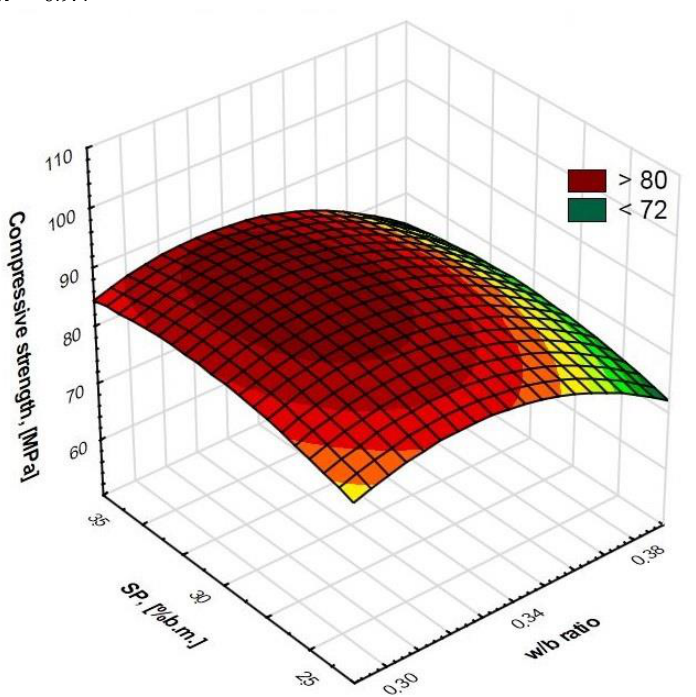
Figure 9. Surface chart. Relationship between w/b ratio and SP on compressive strength. R 2 = 0.97. (2) B -CSF; E